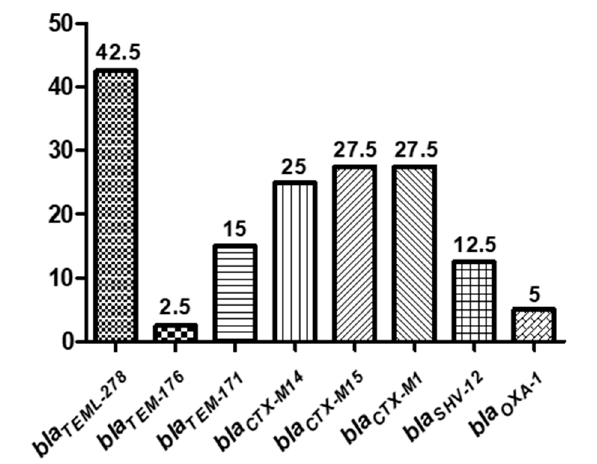
Figure 4. Prevalence (percentage) of β -lactamase genes in Gram negative isolates.